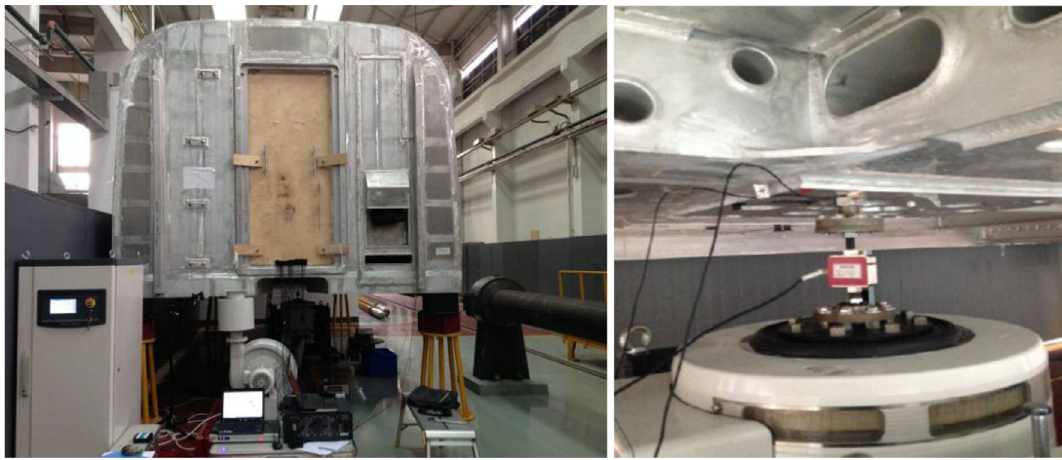
Fig. 6 Installation of exciter and the scene for test